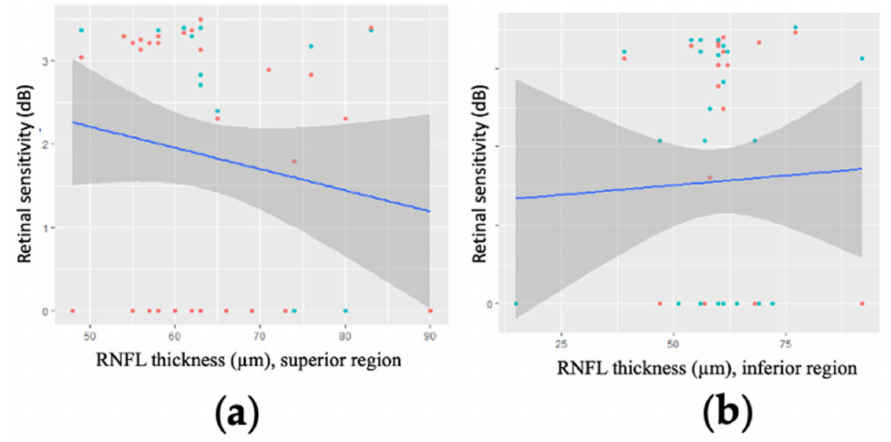
Figure 4. Logarithmic regression modelling of retinal sensitivity as a function of mean retinal nerve fibre layer (RNFL) thickness for 27 patients (29 eyes) with advanced glaucoma for two points in ( a ) the superior part of the visual field ( p = 0.24) and ( b ) the inferior part of the visual field ( p =